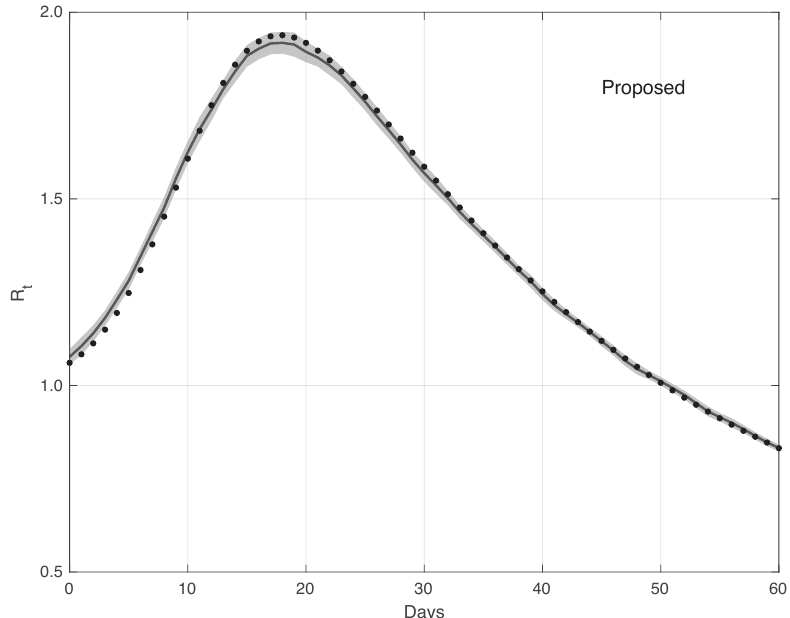
Figure 12. Mean of the R t curve estimated by the proposed method from a realistic SARS-CoV-2 first symptoms synthetic data sample ( n = 100 ) . The relative 95% CI is shown as a grey shadow. The “true” R t sequence is given as a dotted